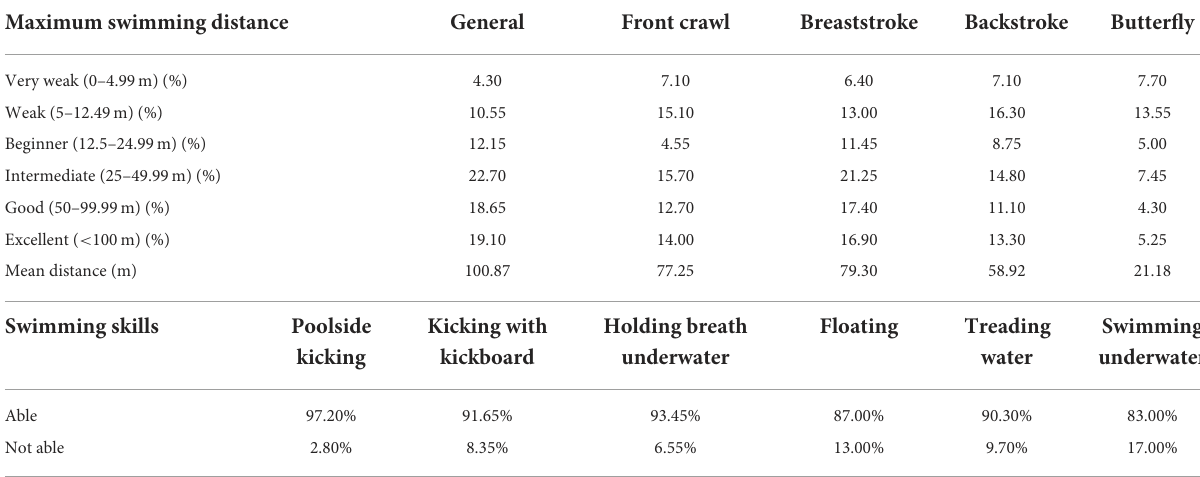
TABLE 1B Descriptive characteristics of the sample.